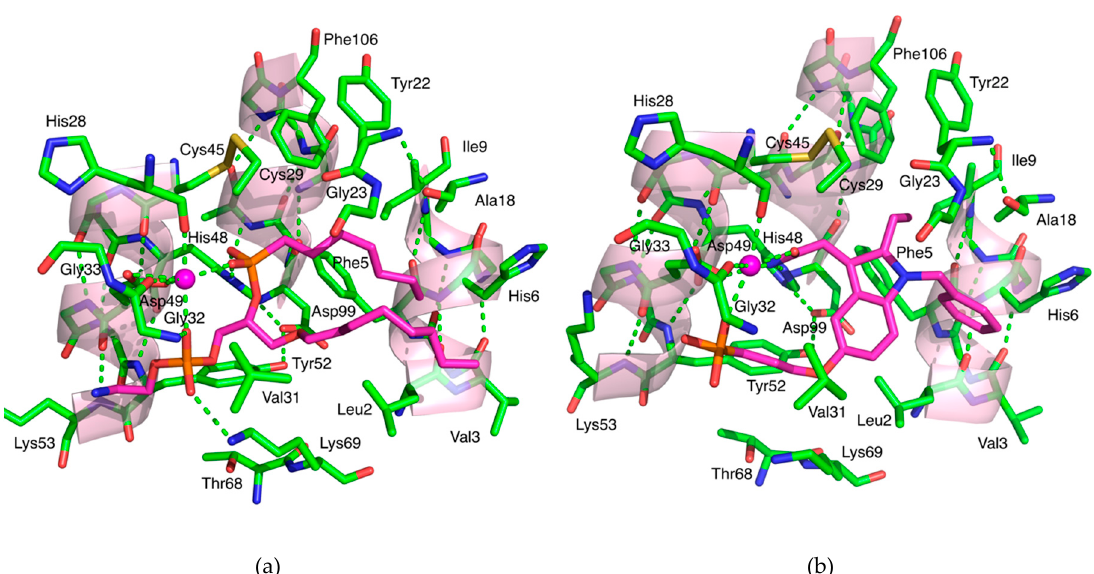
Figure 6. The active site and inhibitors bound from high-resolution crystal structures of hGIIA complexes. Amino acids are depicted if they are within 5 Å of any atom of either inhibitor or the catalytic Asp 99. In addition, contiguous elements of the representation of the main chain of 3 helices (transparent pink cartoon) are provided to aid in an orientation comparison with Figure 2. The carbons of the inhibitors and calcium are coloured mauve. The active site cavity opening is most obviously bounded by Leu2, His6, Ala18, Phe24 and Val31. The main chain of Cys29, Gly30 and Val31 have been removed from the foreground and, as a consequence, the coordination of the calcium by O(Gly 30) is not indicated in both structures or an N(Gly 30) interaction with a phosphonyl oxygen of the transition state analogue. ( a ) The transition state analogue (TSA) L-1-O -octyl- 2 -heptyl-phosphonyl- sn -glycero- 3 -phosphoethanolamine (PDB ID 1POE at 2.1 Å resolution [156]). The two hydrophobic chains of the TSA are relatively parallel, and this structure is the best understanding of the native substrate orientation at the active site channel. The end 3 carbons on the sn-1 chain were not determined, but nevertheless the sn-1 chain is in proximity to the Leu2, Gly30, Val31 and Tyr52, and the sn-2 with Phe5, Ala18, and Gly23; ( b ) The LY311727 (PDB ID 3U8D at 1.8 Å resolution [13]). The two views have been chosen to be similar. For LY311727 the hydrophobic interactions are provided by Leu2, Phe5, His6, Leu20 and Gly30. Figure was created with PyMOL [14].